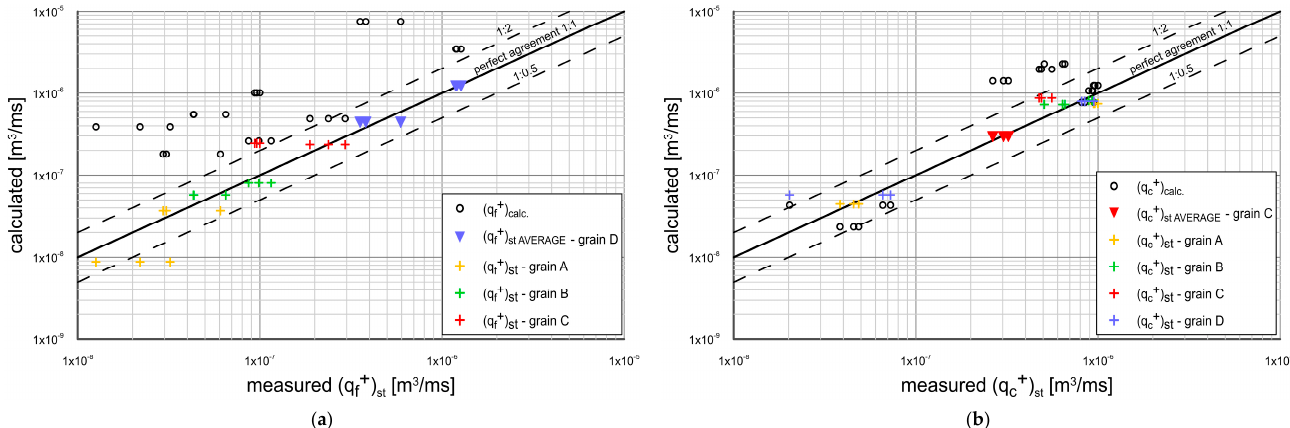
Figure 9. Comparison of calculated and measured transport during ( a ) the crest q + and ( b ) the trough q − .